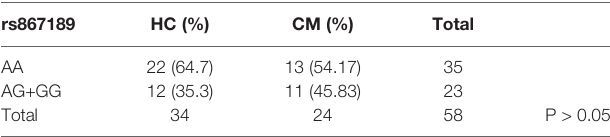
HC, healthy control; CM, cerebral